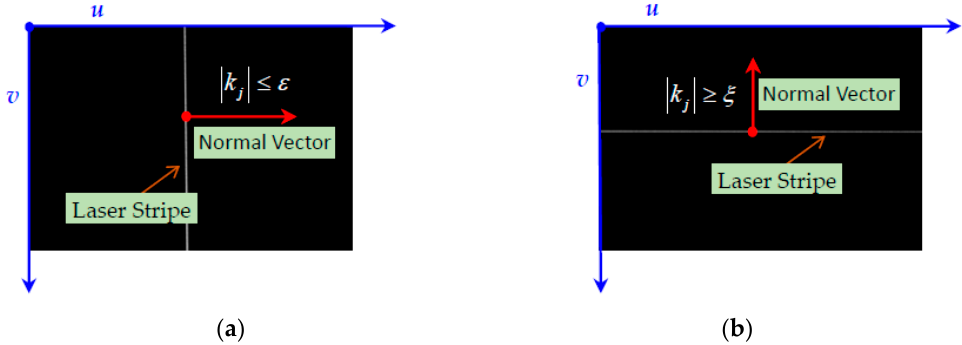
Figure 4. Different normal slope value situations: ( a ) parallel with column; and ( b ) parallel with row.